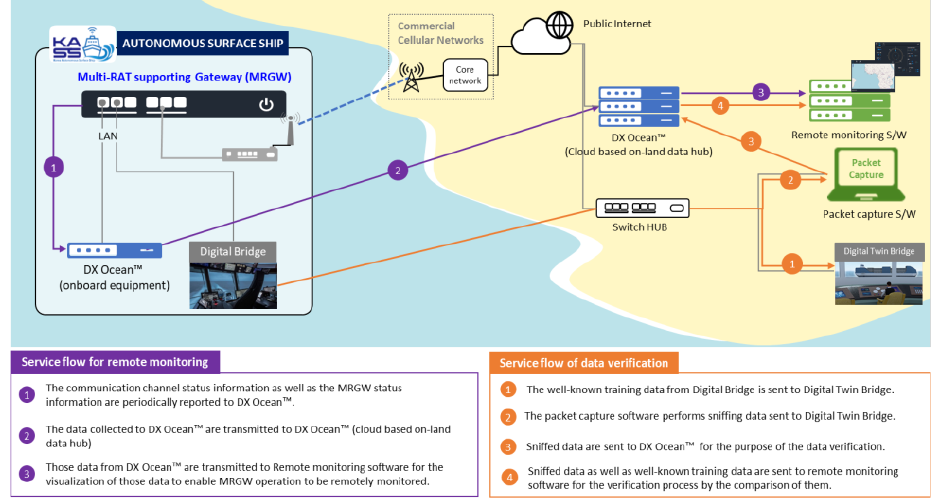
Figure 6. System design for verifying the MRGW’s operation and performance.